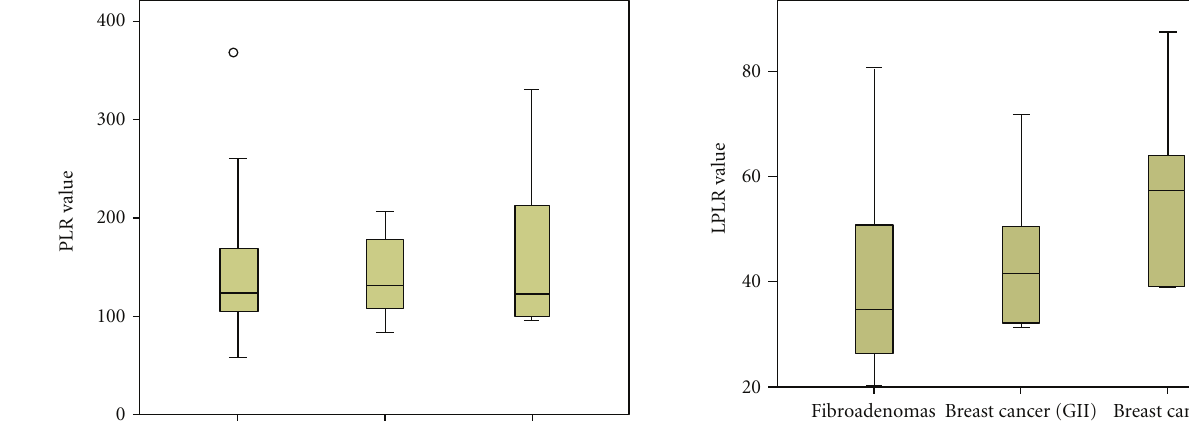
Figure 2: LPLR values within groups A, B, C (fibroadenomas, invasive ductal carcinoma grade II and III, resp.).